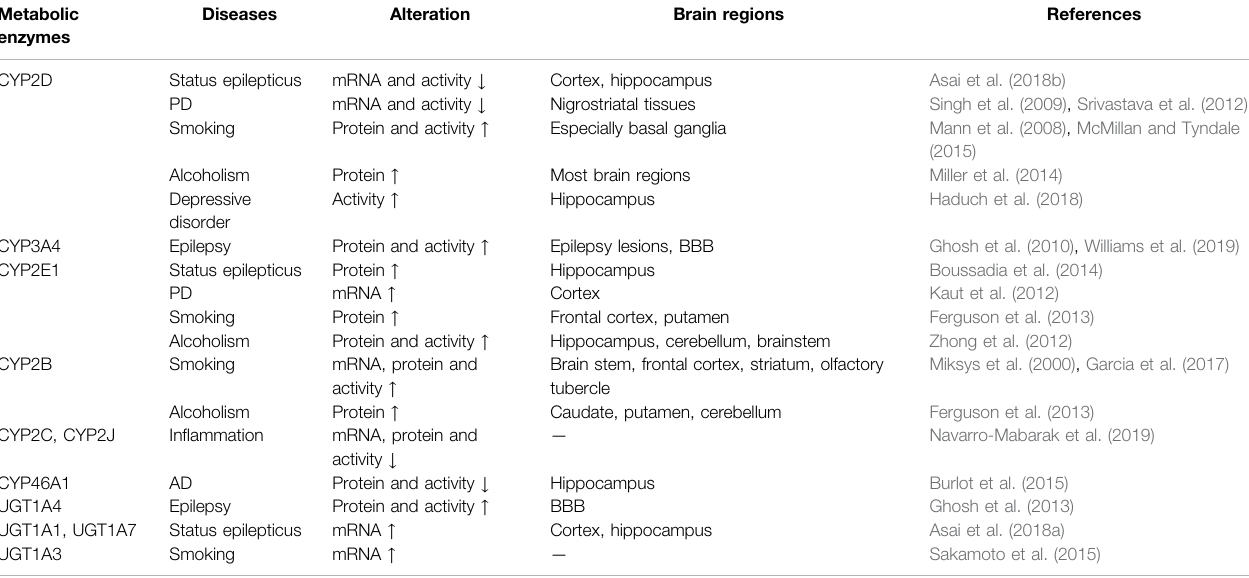
TABLE 1 | The alterations in CYPs and UGTs under diseases. Metabolic